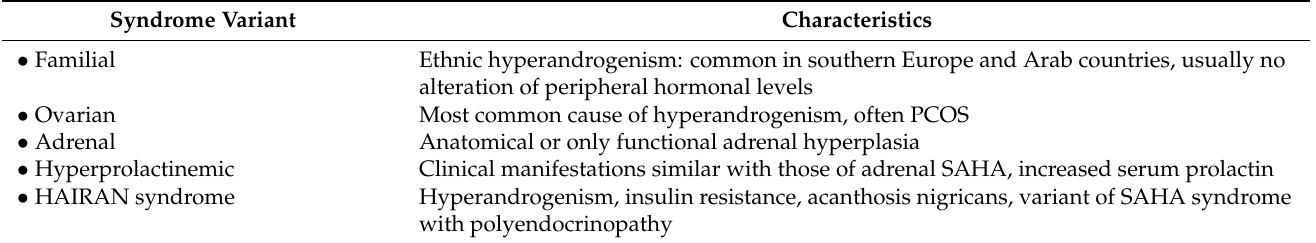
Figure 3. An 18-year-old female patient with SAHA syndrome (HAIRAN variant); seborrhoea, acne, and hirsutism are shown. Further clinical signs: Obesity since childhood, menarche with 11 years, menstruation every 2–3 months, insulin resistance. Right picture reproduced from Chen et al. [87] with permission from Wiley, Hoboken, NJ, USA. Table 2. Classification of SAHA syndrome.